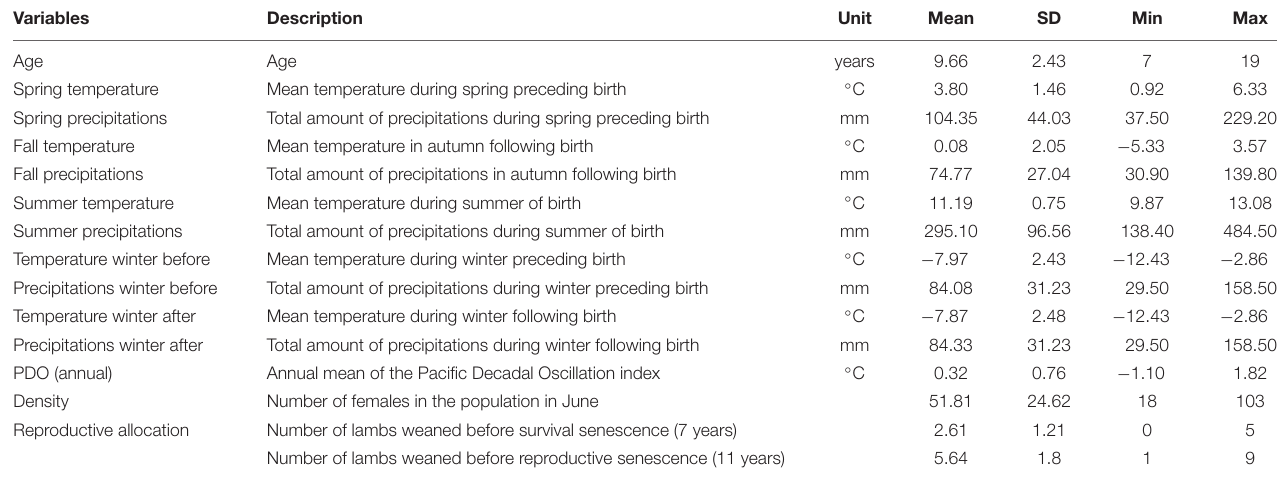
TABLE 1 | Variables included in models of bighorn sheep female survival and reproductive success at Ram Mountain, Alberta,